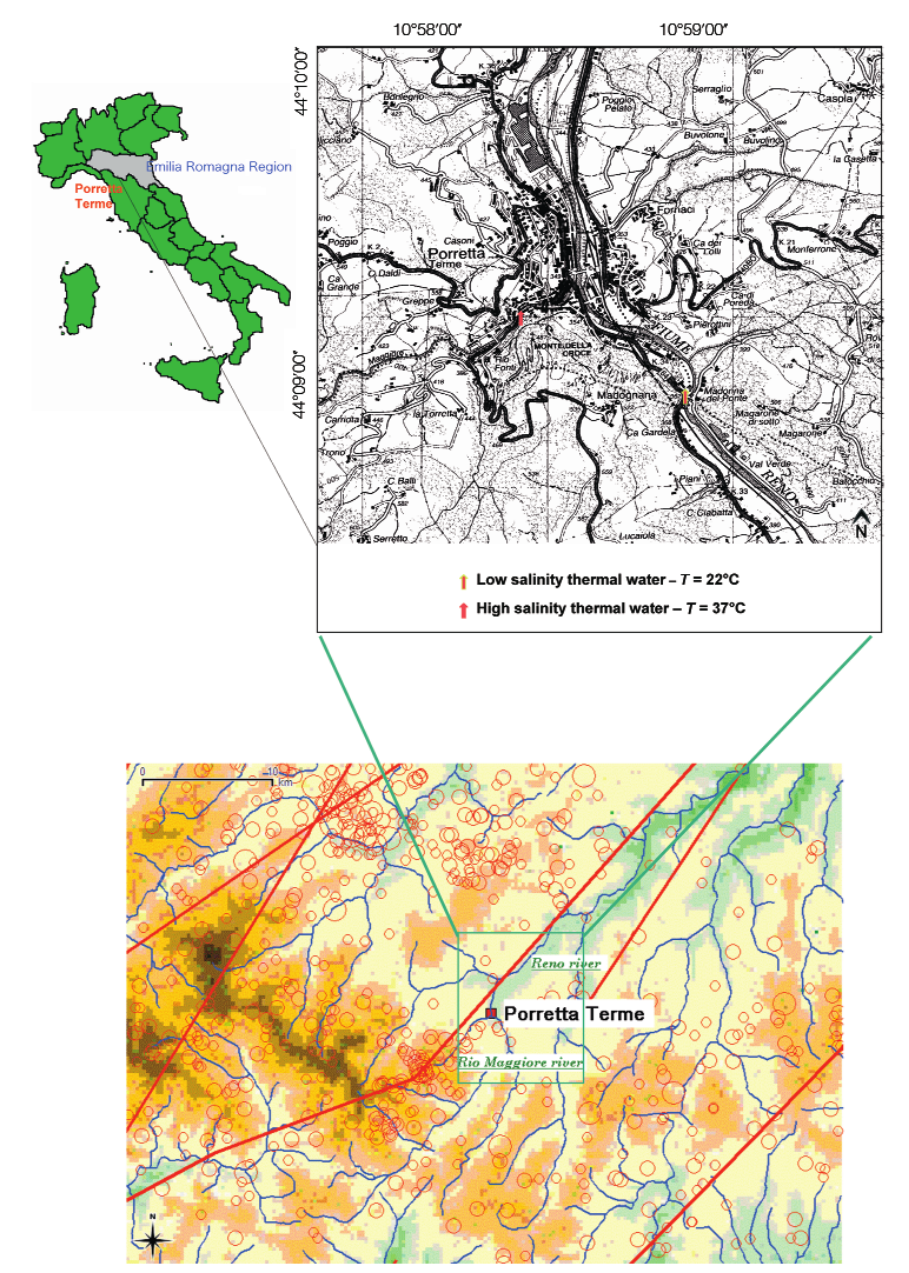
Fig. 1. Location of the investigated area on the Northern Apennines and the recognized tectonic structures (af- ter biblio). The earthquakes that hit the area from 1980 to 2002 (Castello et al. , 2005) and the recent 2003-2005 events are also plotted. It is easy to observe an high density of events on the tectonic line crossing Porretta